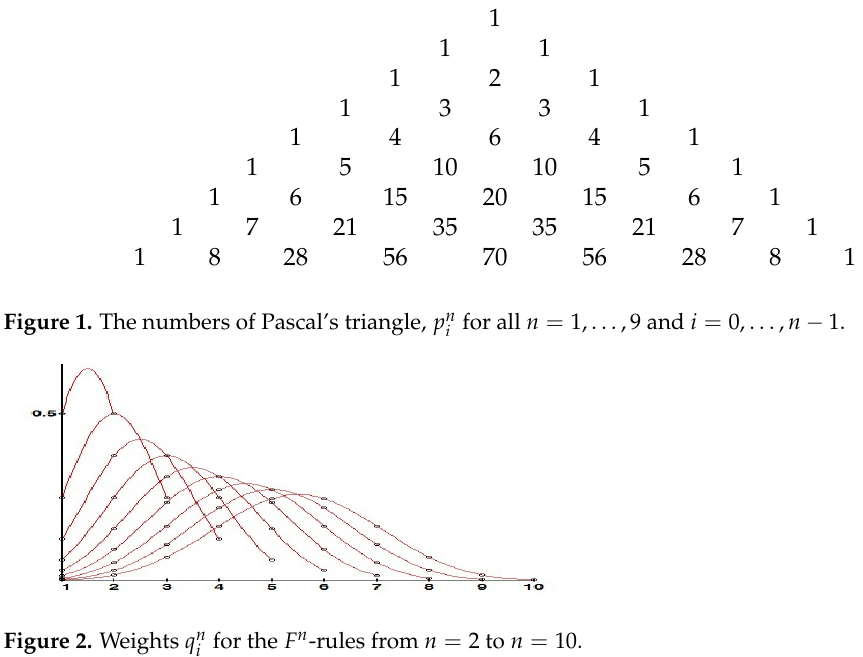
Figure 2. Weights q n for the F n -rules from n = 2 to n = 10. i Variants of the